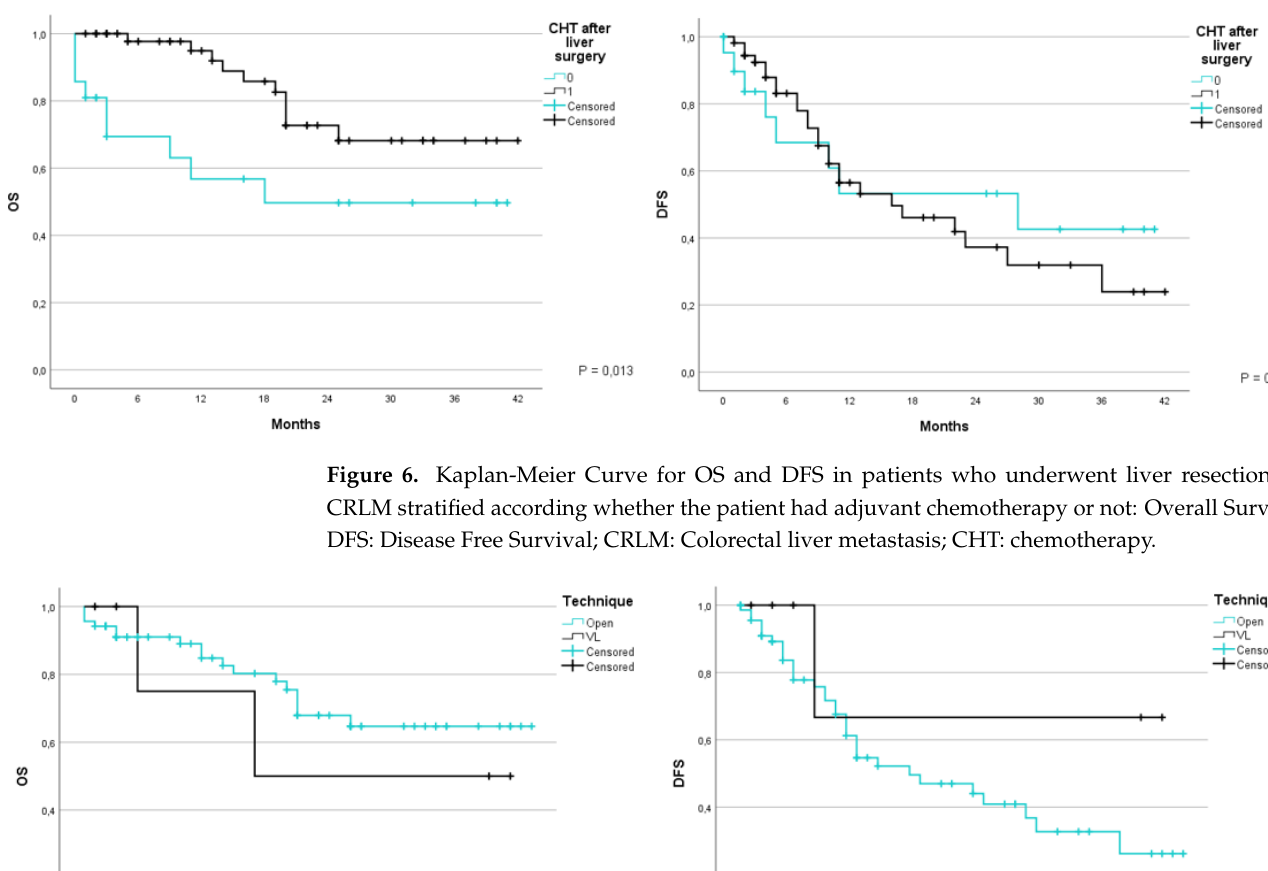
11 of 21 Figure 5. Kaplan-Meier Curve for OS and DFS in patients who underwent liver resection for CRLM stratified according to CEA values. OS: Overall Survival; DFS: Disease Free Survival; CRLM: Colo- rectal liver metastasis.CEA carcinoembryonic antigen. Further studies have been carried out to analyze the correlation between survival and adjuvant chemotherapy. We subdivided the patients in two groups, the first group which did not undergo treatment (0) and the second which did (1). The global survival at 1 and